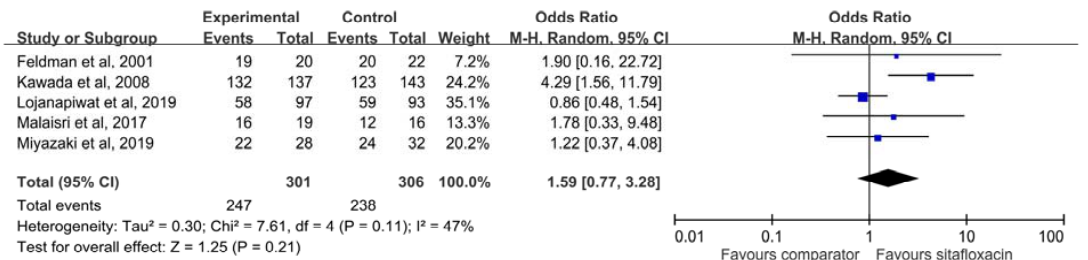
Figure 4. The microbiological response rate of sitafloxacin and the comparator for treating acute bacterial infections.